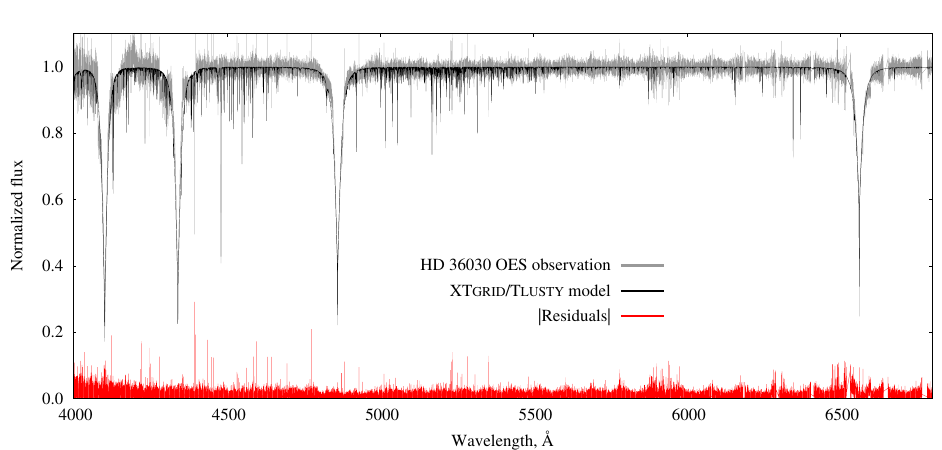
Figure 5. Normalized spectrum (grey line) of HD36030 taken on 29 October 2021 with OES spectro- graph compared with the best-fitting T LUSTY model (black line). The absolute values of the residuals between observed and synthetic spectra are shown in